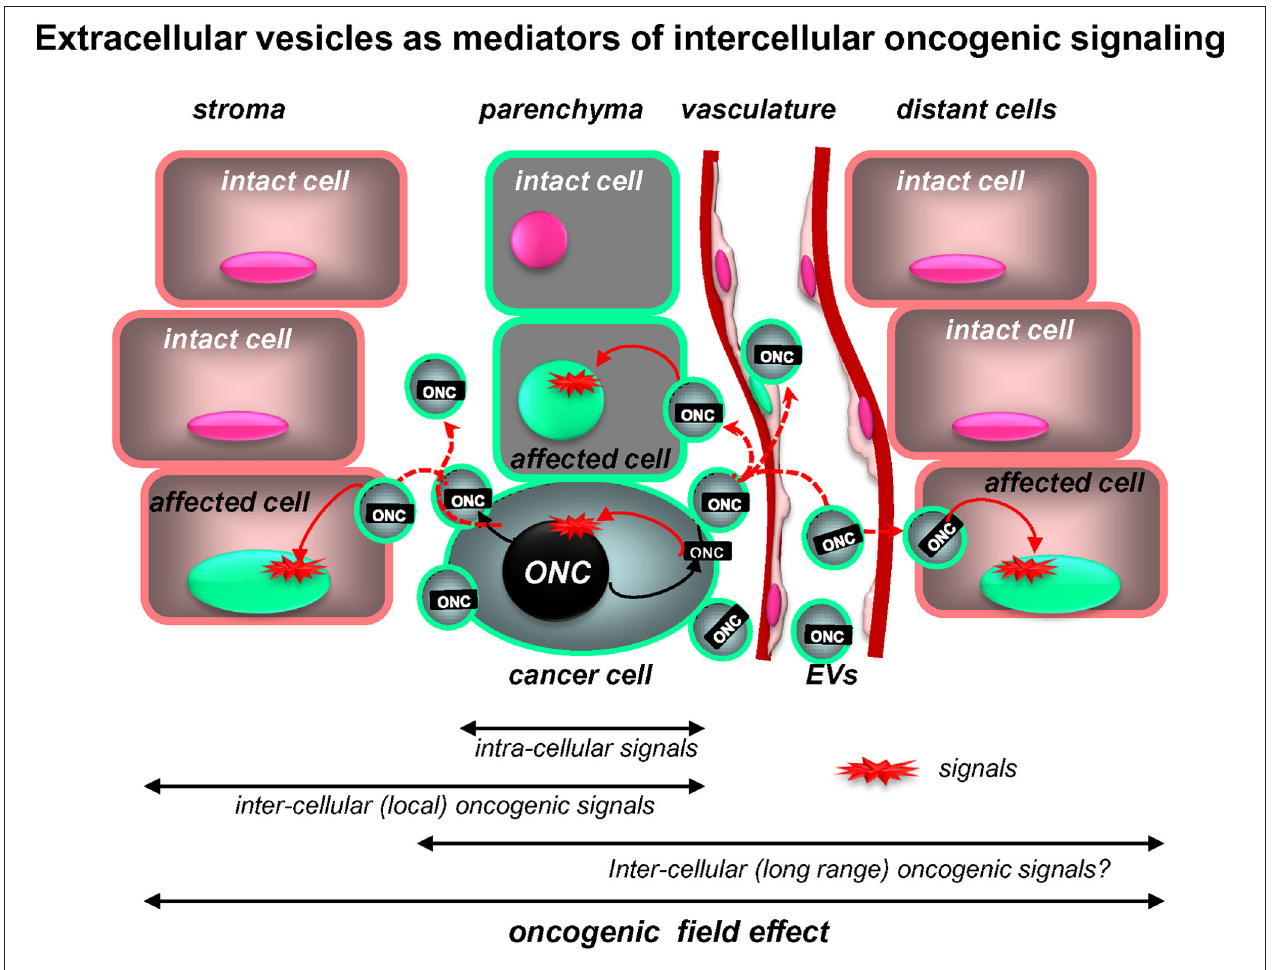
FIGURE 2 | Extracellular vesicles as putative mediators of the intercellular propagation of oncogenic signaling. While intracellular signaling pathways elicited by mutant oncogenes( ONC ) are increasingly well understood, oncoproteins (ONC) may also operate outside of the confines of cancer cells due to intercellular trafficking of their containing EVs (oncosomes). Uptake of this material by proximal